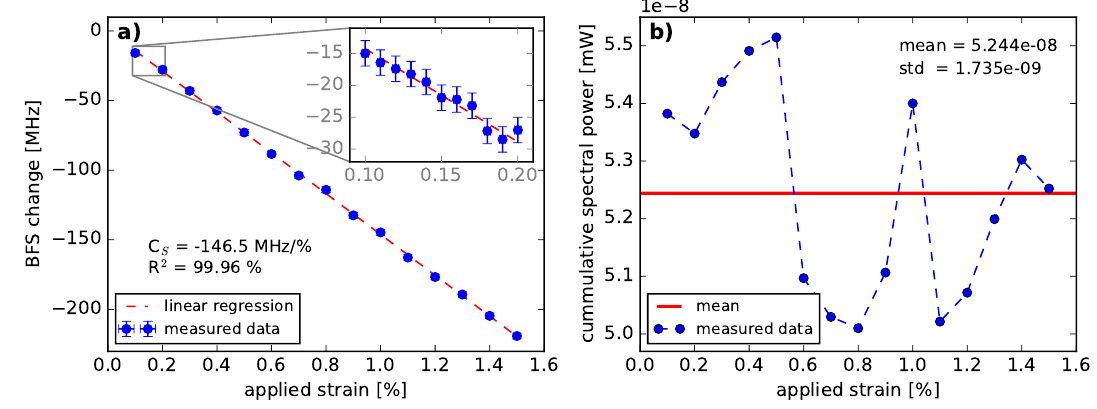
Figure 6. ( a ) Strain-induced change of the Brillouin frequency shift as a function of strain and the calculated strain coefficient of the BFS in the range of 0.1% to 1.5 %. The inset provides a closer view on the measurement data in the range of 0.1% to 0.2 %. ( b ) Cumulative BGS power of the whole measured spectrum as a function of applied strain.